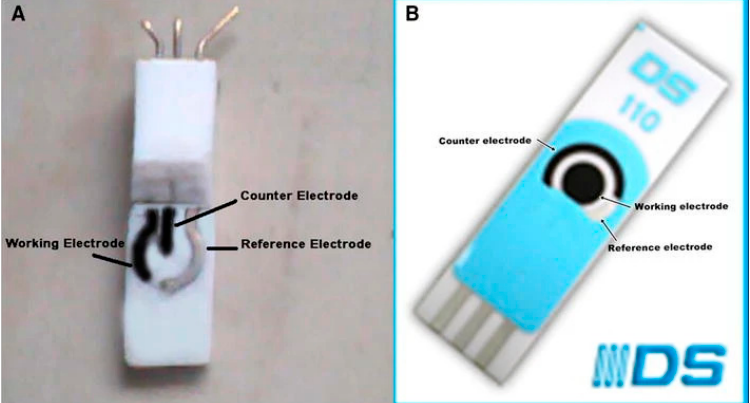
Figure 13. ( A ) Image of carbon nanotube (CCNT) modified electrode ( A ) Image of commercially available screen printed carbon nanotube electrode (DS110CNT). Reprinted with permission from Ref. [81].